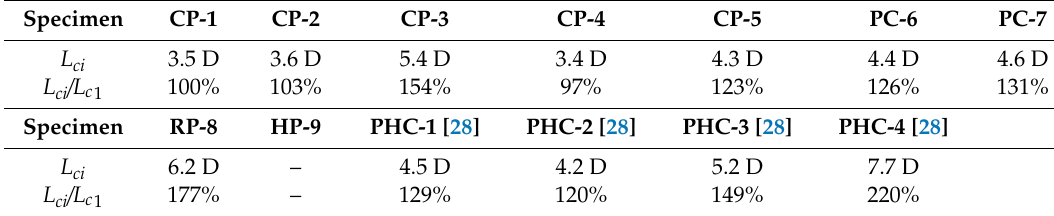
Table 4. Comparison of concrete crushing locations for all the